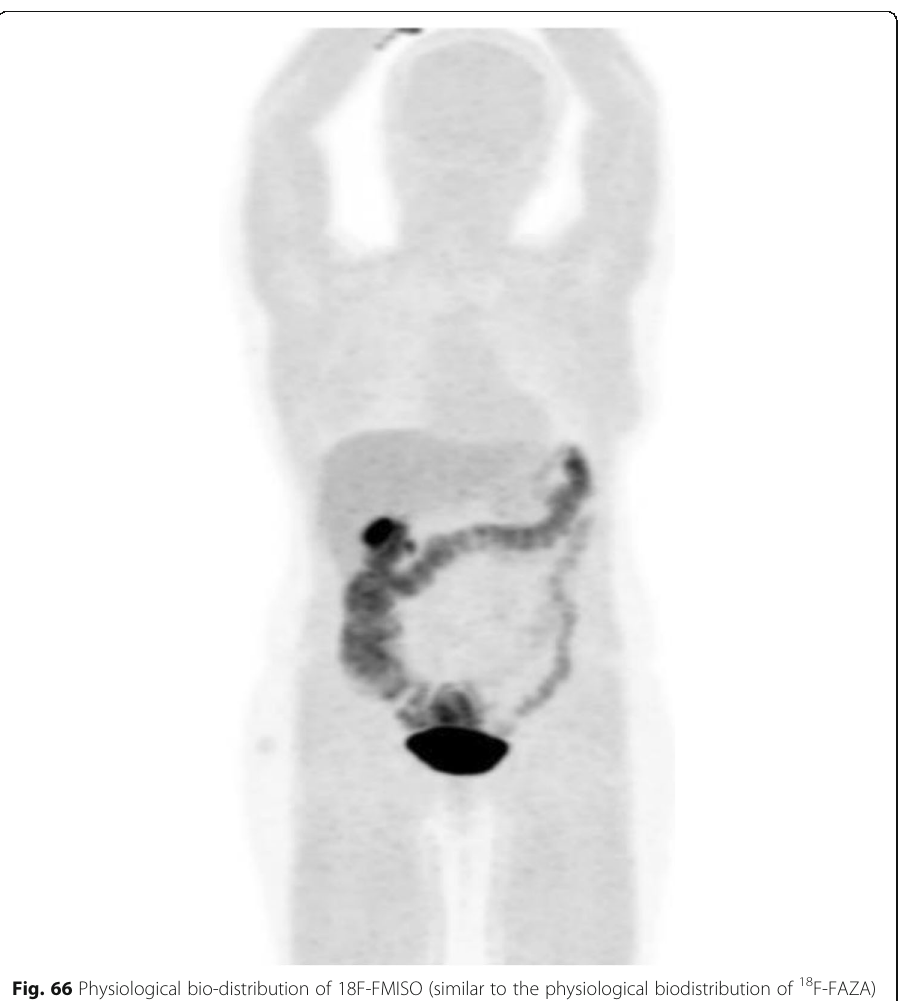
Fig. 66 Physiological bio-distribution of 18F-FMISO (similar to the physiological biodistribution of 18 F-FAZA)